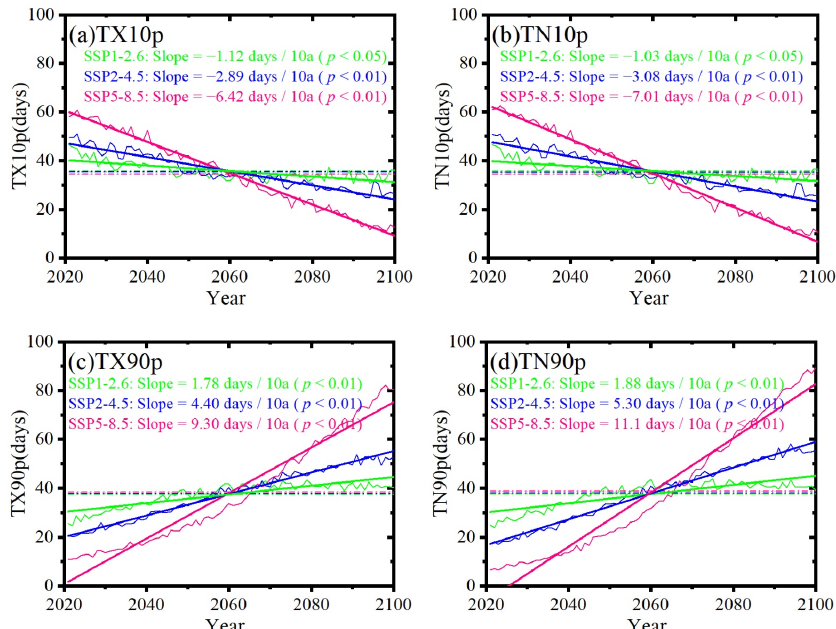
Figure 7. The interannual trends of ( a ) TX10p, ( b ) TN10p, ( c ) TX90p, ( d ) TN90p in mainland China in different SSP scenarios from 2021 to 2100 based on MME. (The curves represent time series values, which are the average values of all pixels in mainland China, straight lines represent trends, dotted lines represent mean values, and green, blue, and purple represent SSP1-2.6, SSP2-4.5 and SSP5-8.5, respectively.).